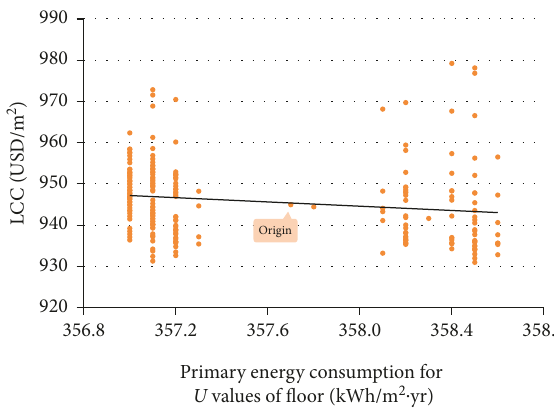
Figure 10: Deriving optimal energy conservation measures of the target building: (a) U value of floor’s alternative derivation according to the U values of floor; (b) U value of floor’s alternative derivation according to the